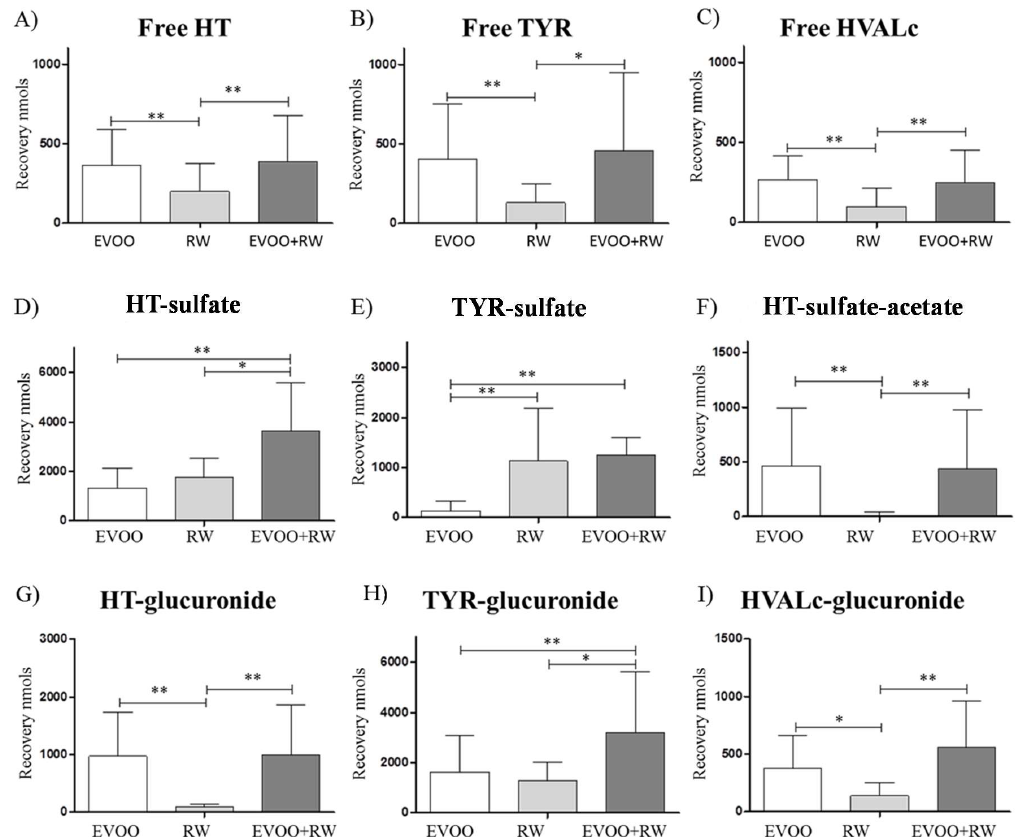
Figure 3. HT and TYR free forms, sulfate, and glucuronide metabolites urinary recovery (nmol) from 0 to 6 h after EVOO, RW, and RW + EVOO ( n = 12) of A ) Free HT; B ) Free TYR; C ) Free HVALc; D ) HT-sulfate; E ) TYR-sulfate; F ) HT-sulfate-acetate; G ) HT-glucuronide; H ) TYR-glucuronide; and I ) HVALc-glucuronide. Data expressed as mean ± SD. * p < 0.05; ** p < 0.01.